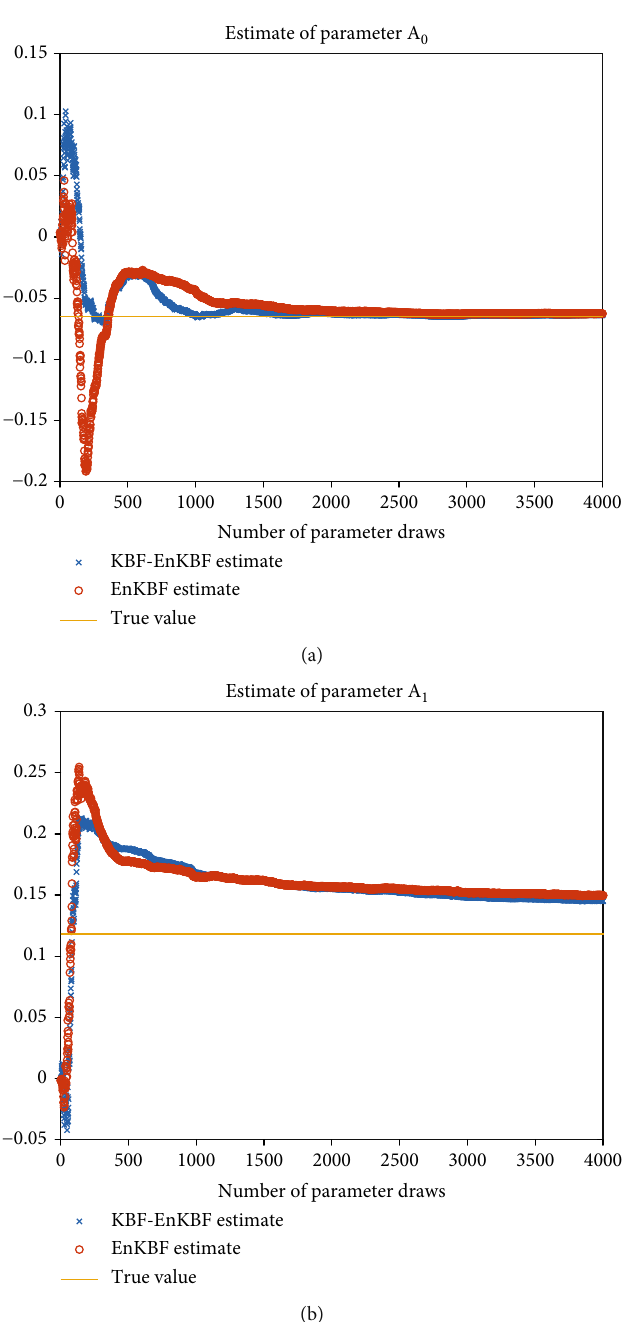
Figure 9: (a, b) are plots for velocity parameters for the fi rst two parameters in λ obtained using KBF-EnKBF and EnKBF dual fi lters, applied to the wave equation (Example 2), with both fi lters run for 1000 time steps. The number of particles, for the state and hyperparameters, used in the EnKBF fi lter is M = 1000 ; the time step size used in both fi lters is dt = 0 : 01 . μ = 0 : 001 and 100 grid points are used. Compared to the results obtained using the Metropolis-Hastings algorithm (Section 7), the dual fi lters register a dismal performance, at least in this